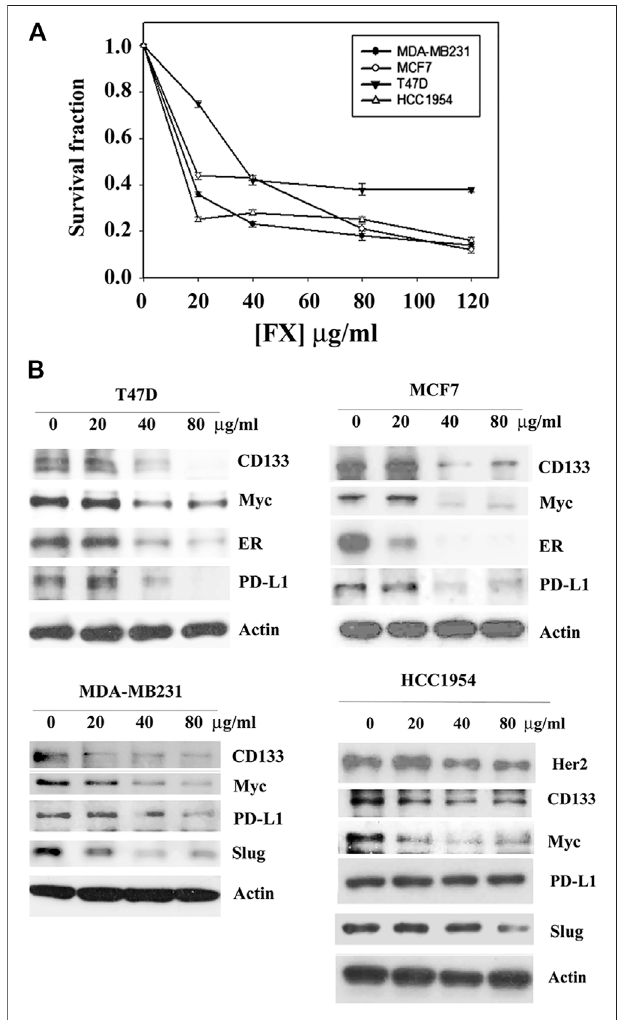
FIGURE 1 | Formula X inhibits cell growth and suppresses oncogenic protein expression in different types of breast cancer cells. (A) The indicated cells were treated with a serial dose of Formula X (FX) for 4 days. The level of surviving cells was determined by MTT assay. All data were obtained from at least two independent experiments. The survival fraction showed the fold change relative to the levels of the untreated control. The data are presented as the mean ± SD. (B) The cells were treated with various doses of Formula X for 24 h. The lysates were prepared, and the effect of Formula X on theselectedproteinexpressionasindicatedinthe fi gurewascharacterizedby Western blotting analysis. Actin staining served as a loading